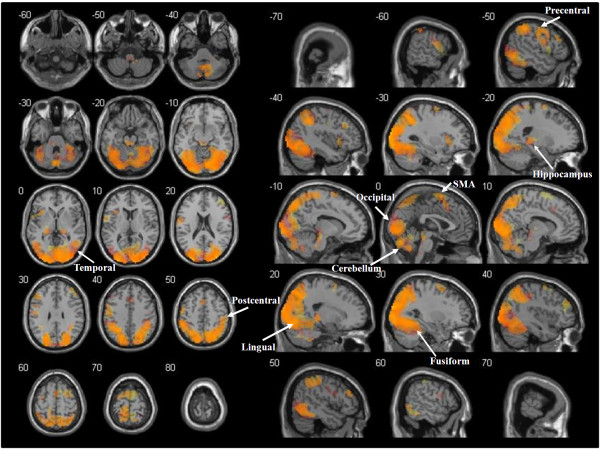
Functional activations for the observation of arm movements and dot trajectories. Cerebral regions involved in both the observation of arm movements and dot trajectories (orange) as revealed by conjunction analysis. The t-maps of AM > IB and DT > IB contrasts at the group level were thresholded (p < 0.05 at cluster-level, FWE corrected), binarised and multiplied voxel-wise with each other to identify common areas of activation. Areas activated only when arm movements were presented are shown in red, while areas activated only when dot trajectories were presented are shown in yellow. Activations are superimposed on the MNI single subject T1 template. The coordinates represented in the upper left corner of each section refer to the MNI stereotactic space.